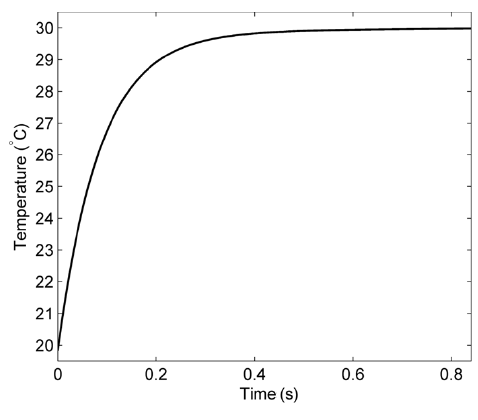
Figure 3. Time taken to reach the steady state within the MOF fiber by plotting the water channel temperature vs . time.